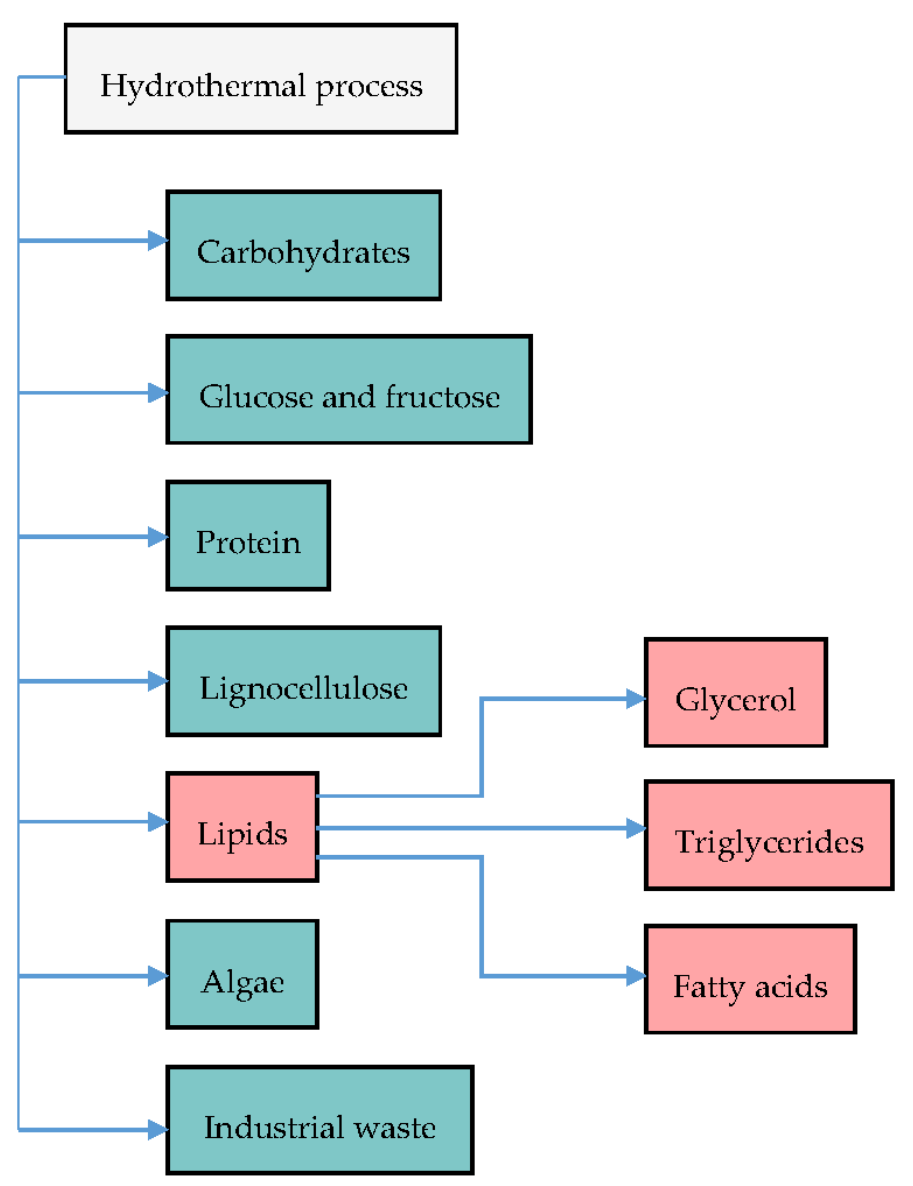
Figure 3. Raw materials used in the hydrothermal process.